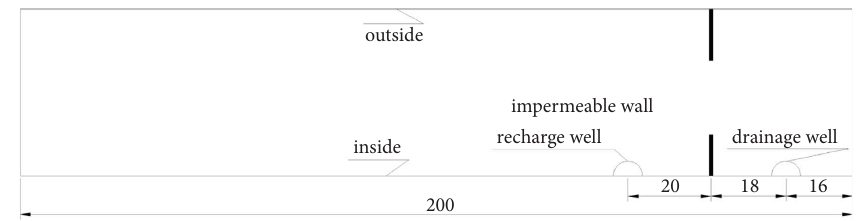
Figure 2: Schematic diagram of indoor seepage groove structure (unit: cm).